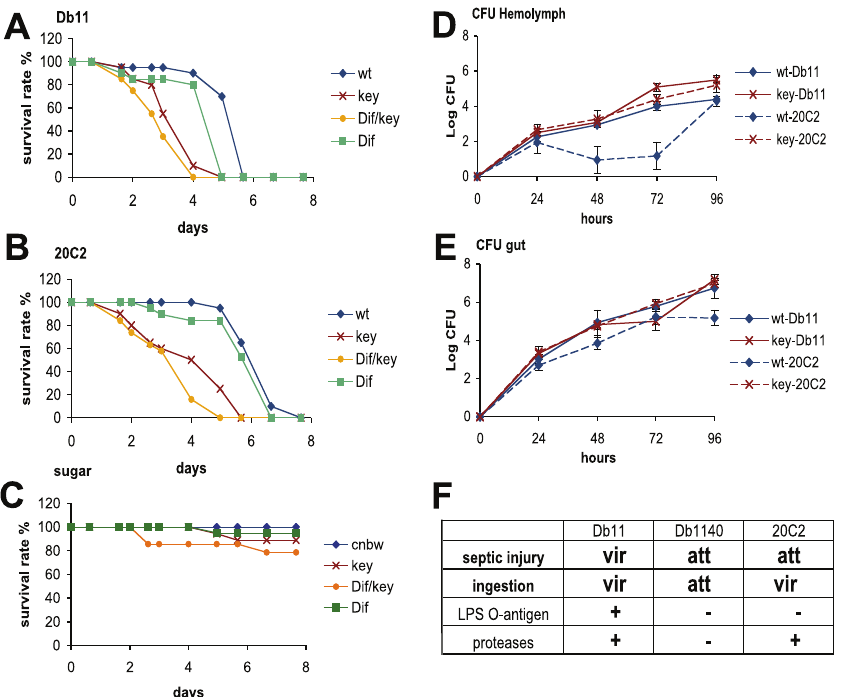
Figure 2. Ingested S. marcescens Db11 Kills Drosophila Flies Slowly (A–C) Db11 (A) or 20C2 (B) bacteria were fed to wild-type (wt) or mutant flies at 25 8 C. Survival is expressed in % of surviving flies. (A) median survival times in days (LT50): wt: 5.7; Dif : 5.0; key : 4.0; Dif . key : 3.0 (the difference between wt and all mutants is significant ( p , 0.0001)); (B) wt: 6.7; Dif : 6.7; key : 4.5; Dif , key : 4.0 (the difference between wt and key is significant ( p , 0.0001)). LPS-defective 20C2 kills wild-type flies more slowly than Db11: LT50 for flies feeding on 20C2 is 6.7 d compared to 5.7 d for flies on Db11 ( p , 0.0001). (C) Flies were fed on a 50-mM sugar solution as control. All three experiments were performed in parallel. (D) The hemolymph of batches of 20 infected flies was collected and plated on LB agar containing the appropriate antibiotics. CFU: colony-forming units (logarithmic scale). The values for the 72-h time point are as follows: wt-Db11-GFP: 4.0 þ /-0.26 (standard deviation); key -Db11-GFP: 5.1 þ /-0.21; wt- 20C2-GFP: 1.18 þ /- 0.8 ; key -20C2-GFP: 4.4 þ /- 0.3 ( n ¼ 4 experiments). (E) Guts were dissected and crushed, and dilutions of the extracts were plated as in (D). Note that flies are continuously feeding on a bacteria-containing sucrose solution. (F) Summary of the properties of the S. marcescens strains used in this study. Vir: virulent; att: attenuated virulence.